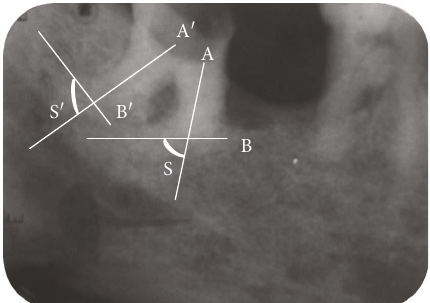
Figure 5: Measurement of Schneider ’ s angle using radiograph. Both S and S ′ are more than 70 ° (severely curved